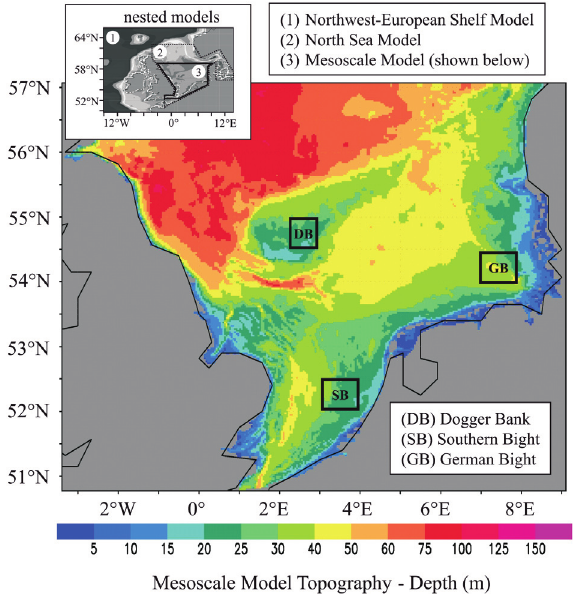
F IG . 1. – Nested model domains (insert) and bottom topography of the meso-scale version of the 3-d hydrodynamic model HAMSOM employed in the present study. The positions of the three spawning (particle release) areas (Dogger Bank, Southern Bight, and German Bight) are also